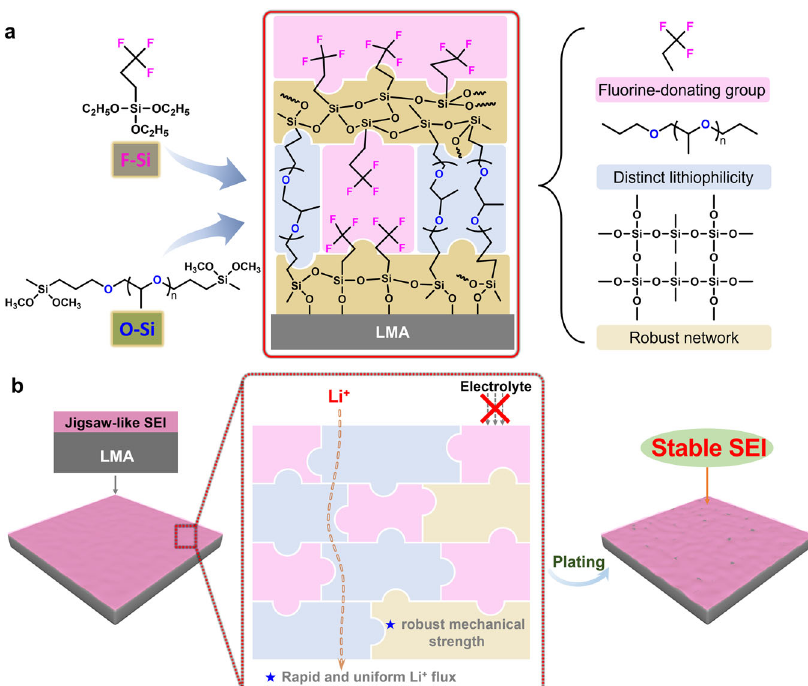
Fig. 1 Schematic diagram of the jigsaw-like arti fi cial SEI. a Schematic illustration of designing multi-component jigsaw-like arti fi cial SEI, where the fl uorine-donating group (i.e., − CF 3 ) could yield a dense structure to prevent the formation of Li dendrites and the decomposition of electrolytes, the ethylene glycol backbone is favorable for rapid Li + transport, the robust cross-linking network could endow the SEI layer with excellent mechanical strength. b Stable Li plating/stripping behavior of LMA with jigsaw-like